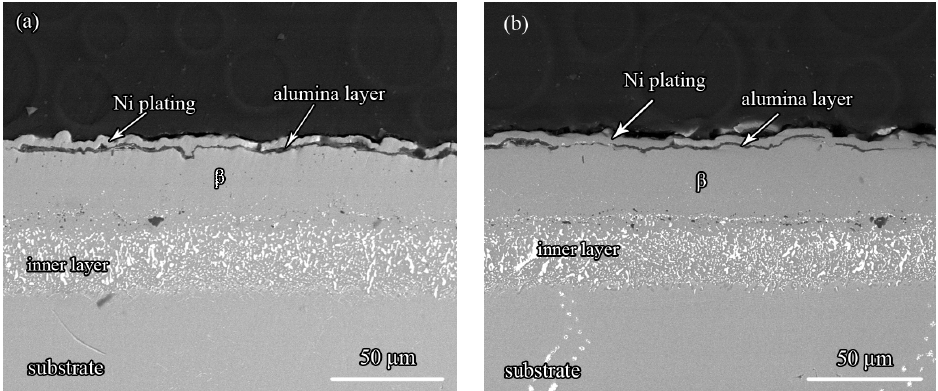
Figure 9. The cross ‐ sectional morphologies of the coatings after oxidation at 1100 °C for 2 h: ( a ) PtAl; ( b ) PtZrAl.